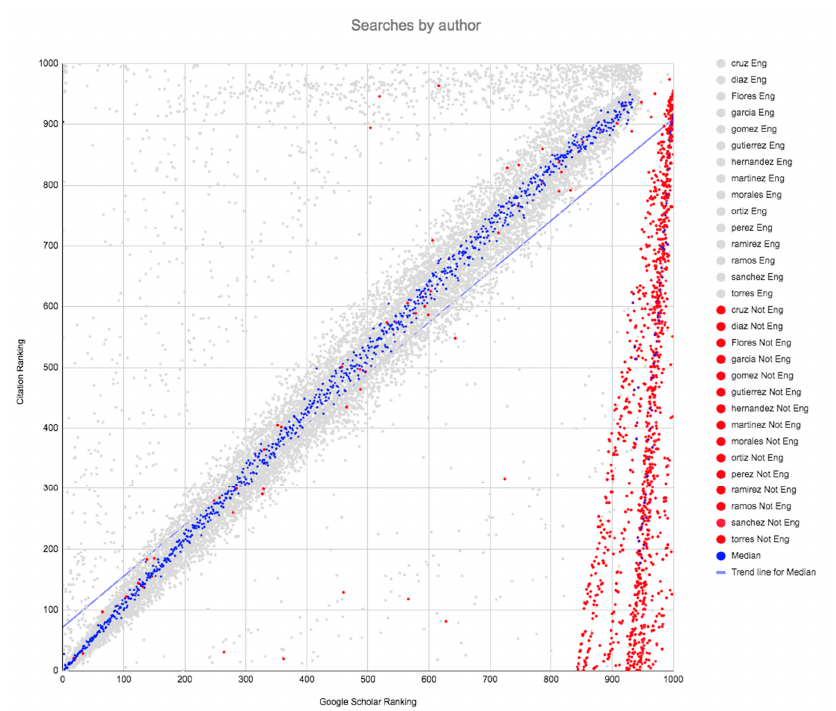
Figure 2. Scatter plot of searches by author.